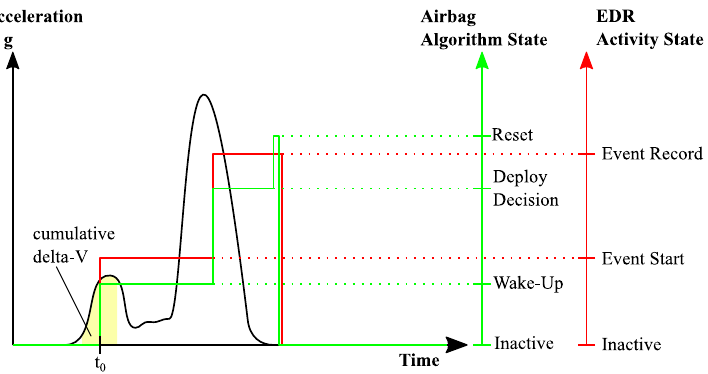
Figure 4. Exemplary mapping of crash activity to airbag algorithm states and EDR activity states.